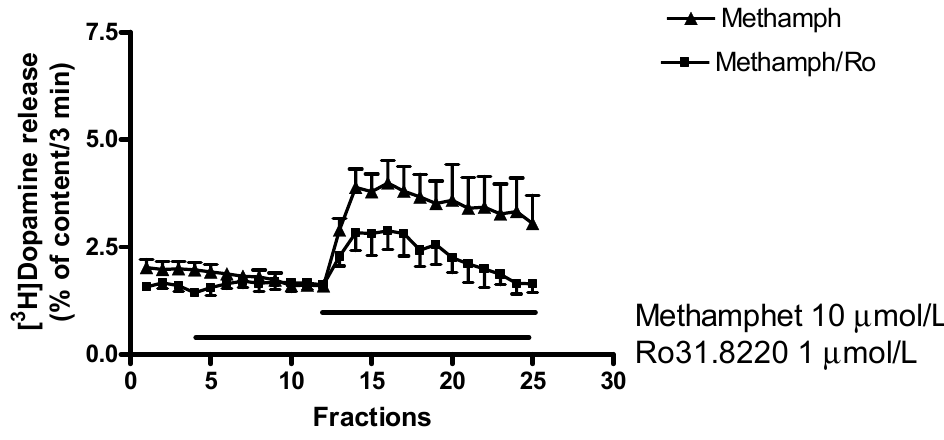
Figure 14. Ro31-8220 decreased the ( ± )methamphetamine (methamph)-induced non-vesicular. [ 3 H]dopamine release in rat striatum. For the experimental procedure, see Figure 2B. ( ± )Methamphetamine was added to striatal slices from fraction 12 in a concentration of 10 µ mol/L in the presence and absence of Ro31-8220. Ro31-8220 (1 µ mol/L) was added to striatal slices from fraction 4 and drugs were maintained through the experiment. ( ± )Methamphetamine-induced non-vesicular [ 3 H]dopamine release was 13.31 ± 2.67 and this release was decreased to 4.57 ± 1.48 percent of content by 1 µ mol/L Ro31-8220, p < 0.05. Student t -statistics for two-means, mean ± S.E.M., n = 4-4.